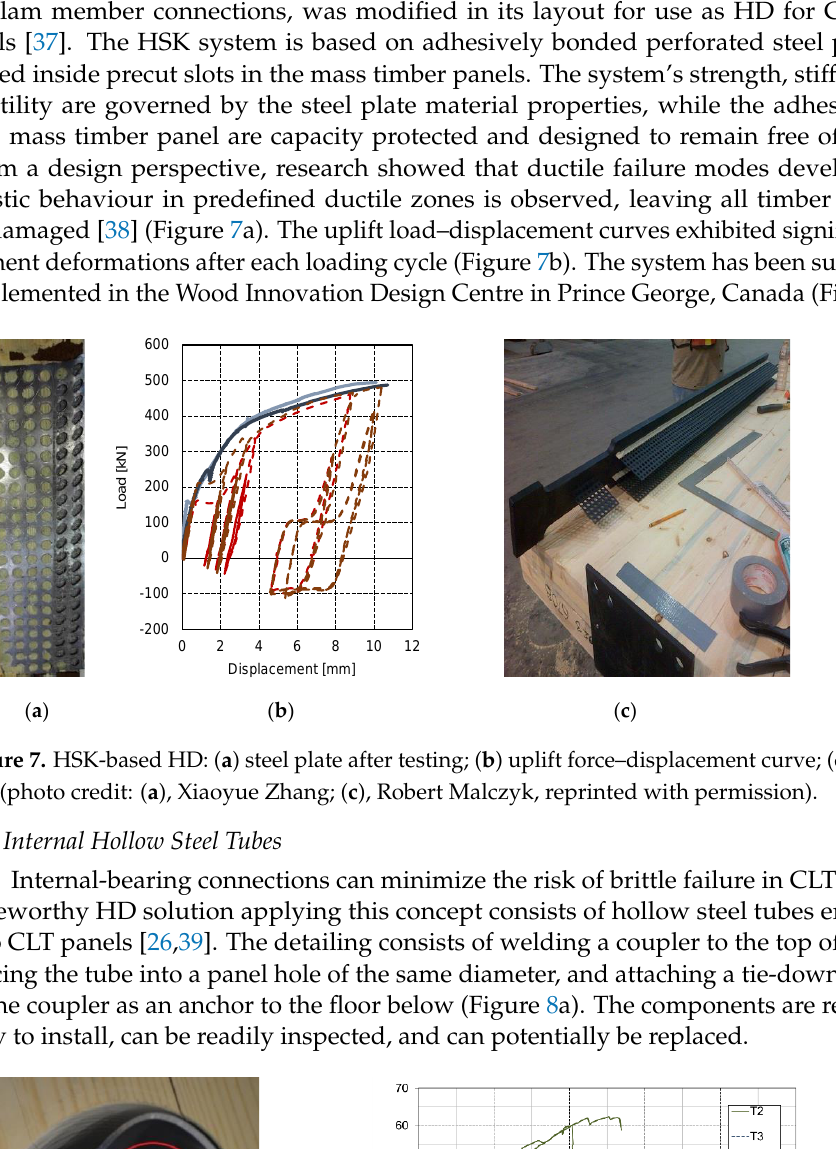
Figure 6. X-RAD system: ( a ) HD connector (photo credit: Rothoblaas, reprinted with permission); ( b ) force – displacement curves and failure modes (photo credit: Andrea Polastri, reprinted with per- mission).